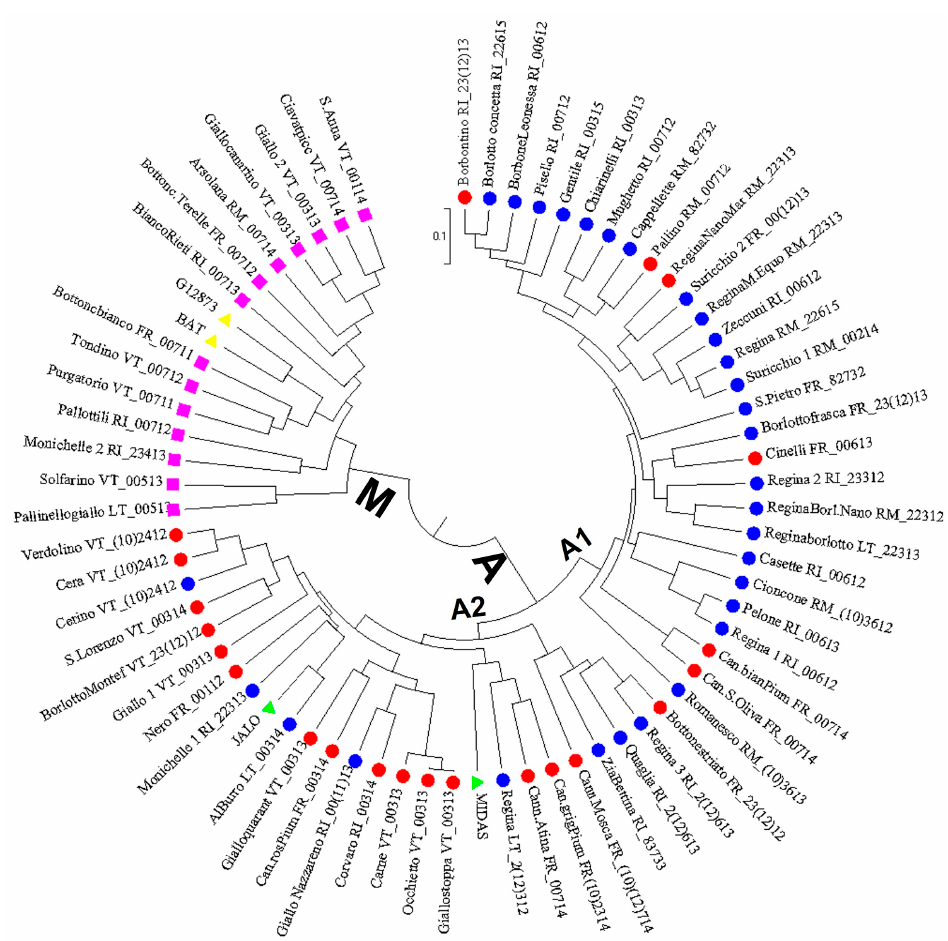
Figure 3. Dendrogram of the genetic relationships among the 66 P. vulgaris landraces from the Lazio region generated with Nei’s coefficient [59] and UPGMA cluster analysis. In the phylogenetic tree, the blue and red circles and the pink square indicate the landraces with C, T, and S PHAS types, respectively. The genotypes BAT and G12873 of Mesoamerica origin (yellow triangles) and MIDAS and JALO of Andean origin (green triangles) were included as references. The numerical code for the seed morphotype is also reported for each landrace.